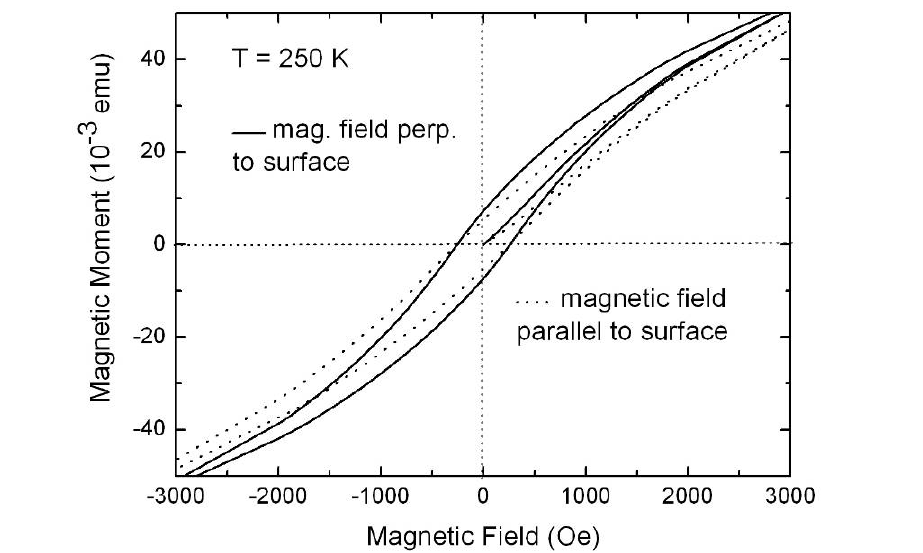
Figure 27. Magnetization curves of a Co-filled porous silicon sample. Co is precipitated in spherical and ellipsoidal particles reaching a maximum length of 200 nm (diameter ~60 nm). The low anisotropy between the two magnetization directions can be ascribed to the small aspect ratio of the deposits but show also that the particles within one individual pore do not strongly interact among each other [120].